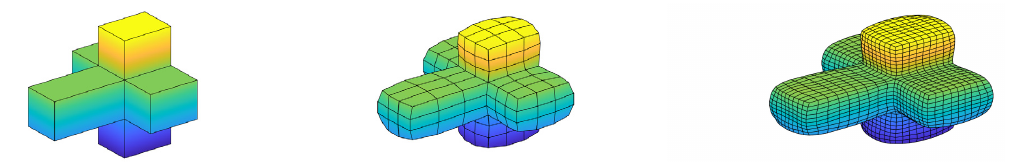
Figure 19. Subdivision surface of space with NULTISS. Left to right; initial mesh; mesh after one refinement; mesh after two refinements. 6. Discussion In this paper, a novel method of curve subdivision based on non-uniform four-point ternary interpolation is proposed. Compared with uniform interpolation, the limit curve